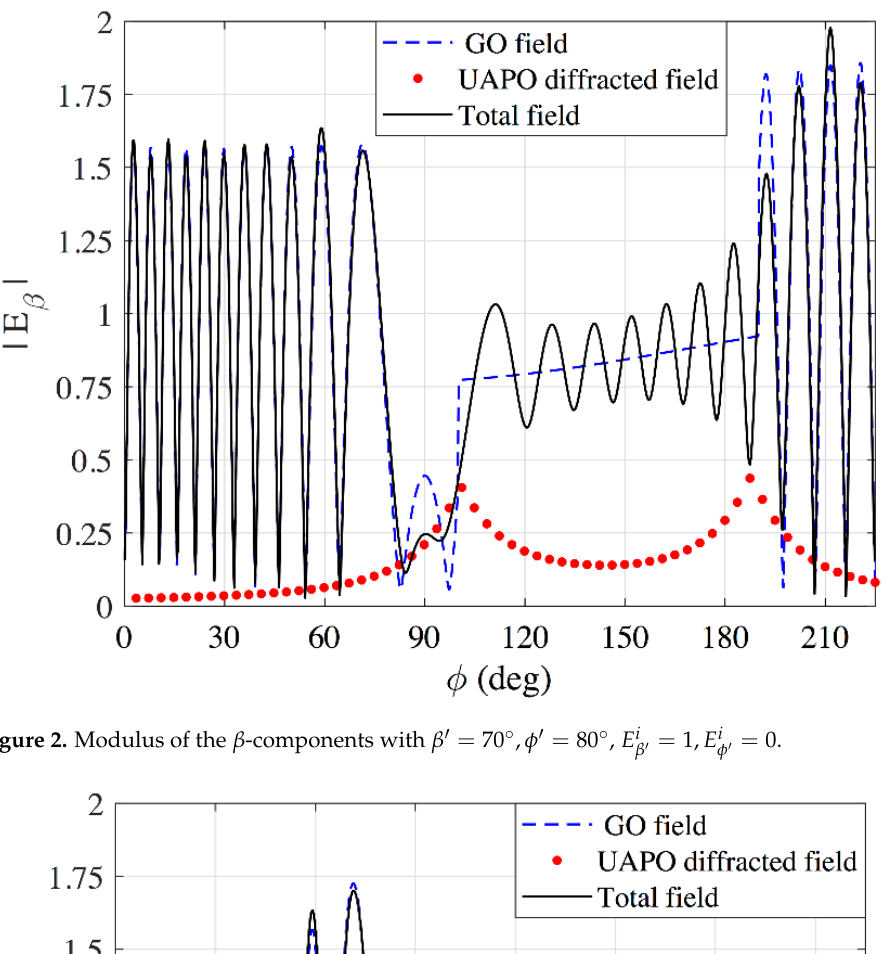
Figure 2. Modulus of the β -components with β (cid:48) = 70 ◦ , φ (cid:48) = 80 ◦ , E i